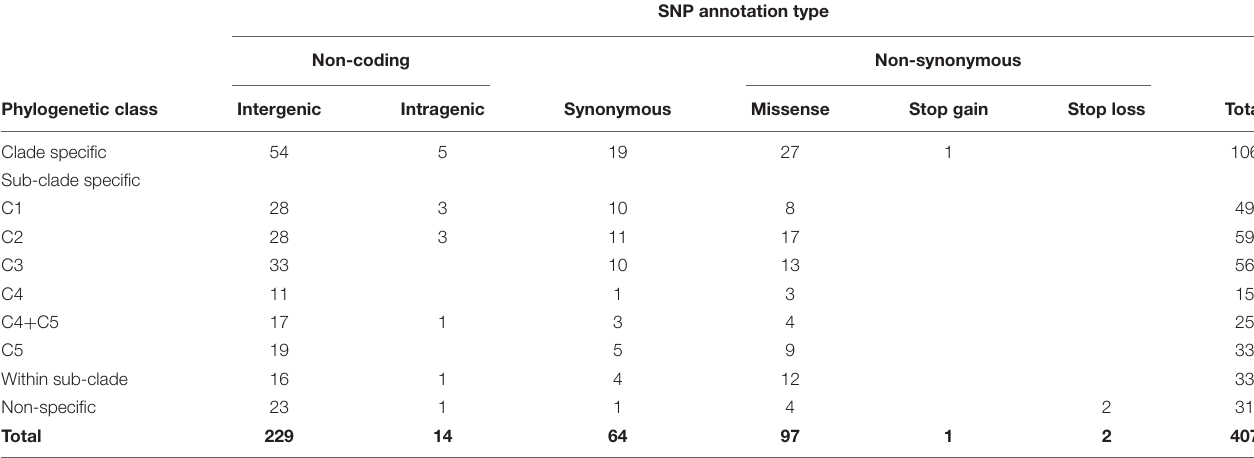
TABLE 3 | Distribution of Macadamia integrifolia chloroplast SNP variation by annotation type and phylogenetic